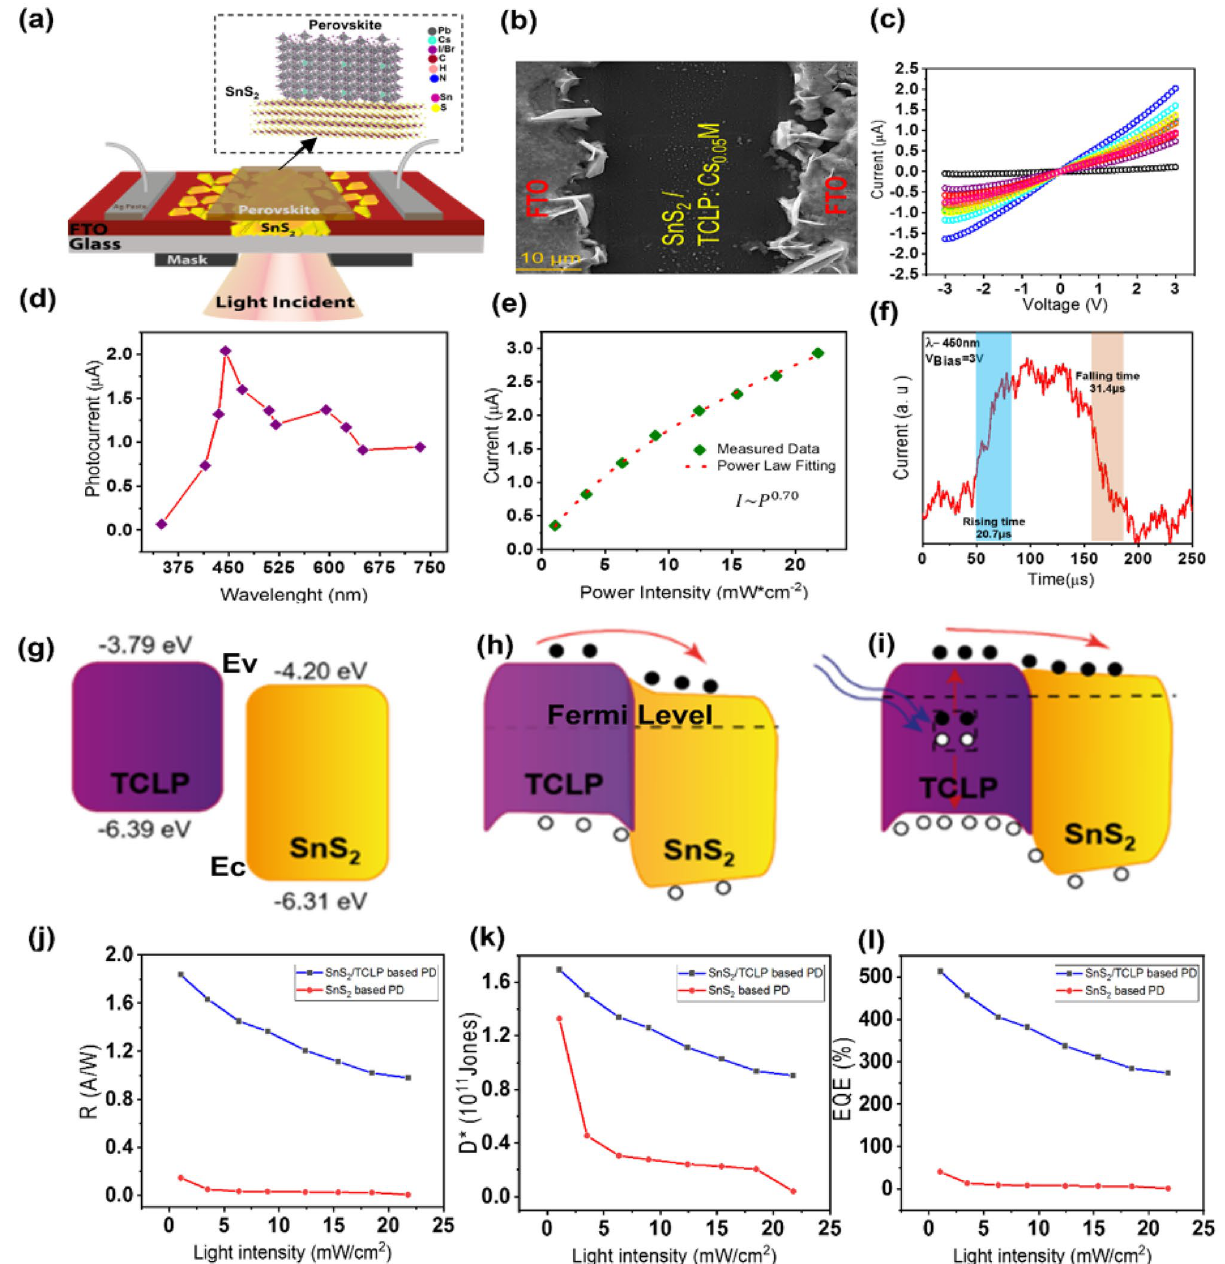
Figure 6. Photoresponces of SnS 2 /TCLP device. ( a ) The schematic of the planar SnS 2 /TCLP photodetector. (Inset: The SnS 2 /TCLP layer in its atomic structure). ( b ) The top view FESEM of deposited TCLP layer on grown SnS 2 nanosheet on patterned FTO ( c ) The I–V curves and ( d ) photocurrent at 3 V bias, for different wavelengths at the light intensity of 5 mW/cm 2 ( e ) Dependence of photocurrent with different light intensities of λ = 445 nm at 3 V, regarding power-law fitting; and ( f ) Time-resolved photoresponse at 5 mW/cm 2 light intensity of λ = 445 nm at 2 kHz on/off cycle. The band diagram energy of the SnS 2 and TCLP layers ( g ) before connection together, after connection together ( h ) in the dark ( i ) under the illumination. The evolution of photodetector parameters, ( j ) responsivity, ( k ) EQE% and ( l ) detectivity as a function of light intensity for Pristine SnS 2 and SnS 2 /TCLP based photodetectors at 445 nm of incident light with different 1 Hz (Fig. S7d) and 2 kHz (Fig. S7e) frequency under the wavelength of 445 nm at 3 V bias represent repeatable and stable performance with the on/off ratio of ~ 40. One sequence of 2 kHz on/off cycle on SnS 2 /TCLP device under light illumination of 445 nm, as shown in Fig. 6f, indicates the rise and falling times shortened one order of magnitude, as fast as 20.7 µs and 31.4 µs, respectively. Increasing the current in darkness or under light irradiation is due to enhancement of the charge carriers’ concentration by the evolution of the band structure of the SnS 2 nanosheets in junction with the TCLP layer. To